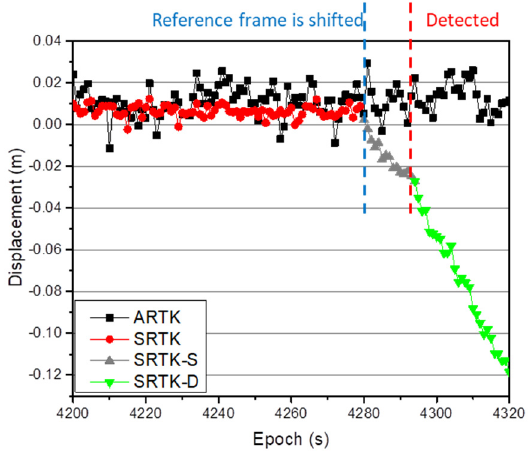
Figure 9. Enlargement of the epoch in which the displacement of the reference station is detected to exceed the threshold value.